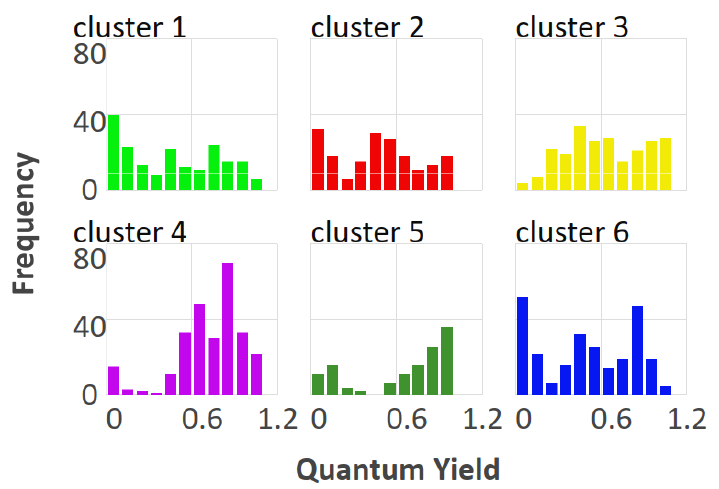
Figure 6. Frequency diagram for the quantum yield for a six-cluster dataset of 115 BODIPYs. The total frequency diagram for the quantum yield is shown in Figure 1d. For the key for the clusters, see Schemes 1 – 6.